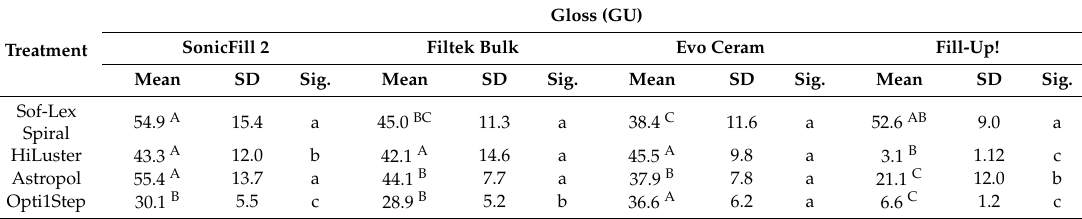
Table 4. Descriptive statistics of gloss (GU). Uppercase letters label statistically significant di ff erences among finishing systems per se. Lowercase letters label statistically significant di ff erences among finishing systems within each restorative material. Uppercase letters label the statistically significant di ff erences among the four materials within each treatment ( p <